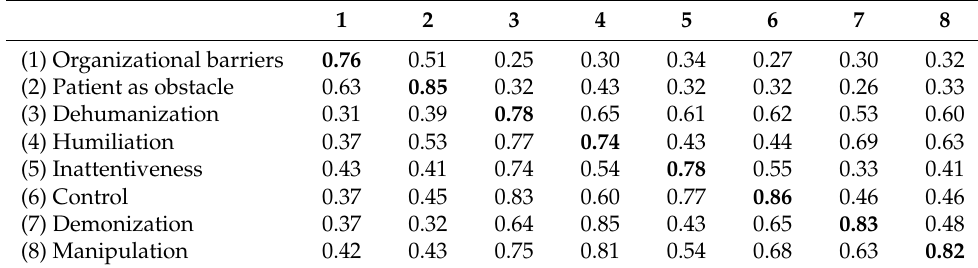
Table 2. Discriminant validity.